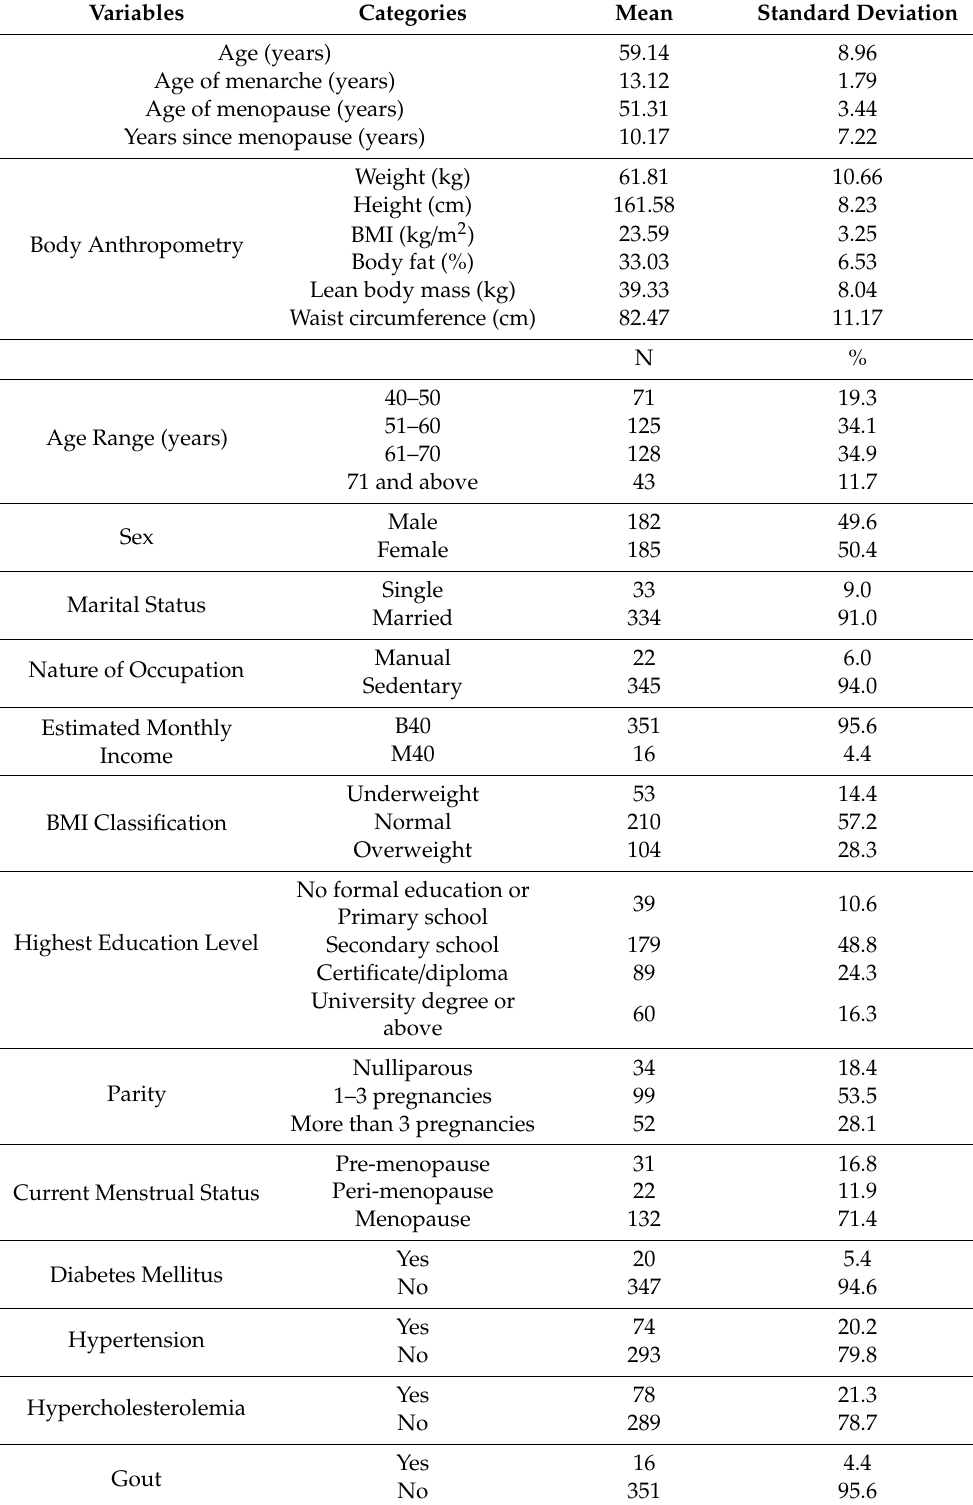
Table 2. General characteristics of the study population. B, bottom; M,